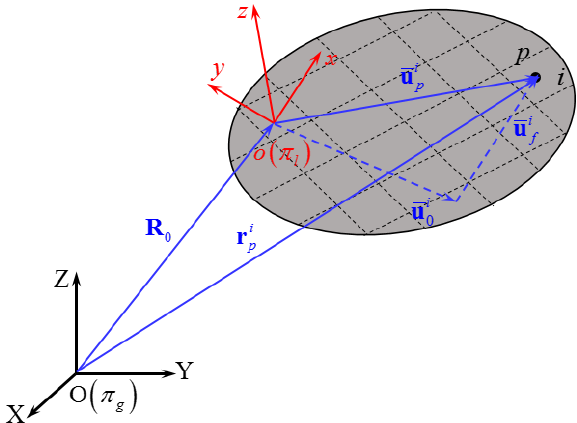
Figure 1. Vector description of floating frame of reference.